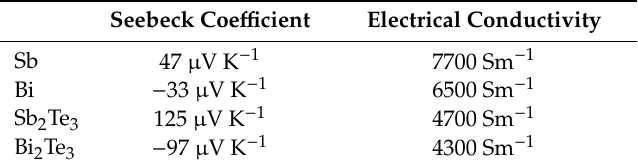
Figure 3. ( a ) The preparing process of the three-layer TFTED; ( b ) The open output voltage of the TFTED as function of temperature difference and the cross-section image; and ( c ) An illustration of the laser power measurement application by using TFTED and the continuous response testing. Table 2. The room-temperature thermoelectric properties of the thin